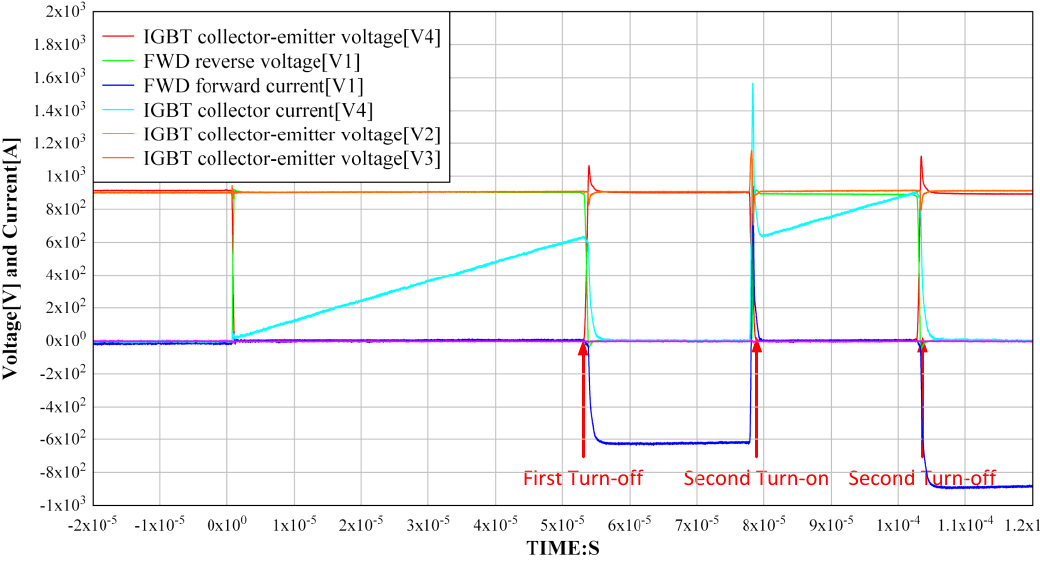
Figure 18. The sequence of double-pulse test.